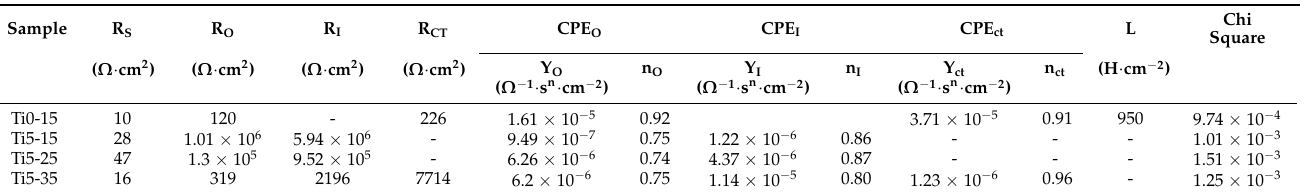
Figure 10. Equivalent circuits used to fit the EIS plots of ( a ) Ti5-15 and Ti5-25, ( b ) Ti0-15 and ( c ) Ti5-35. Table 6. Electrochemical parameters of EIS of Ti0-15, Ti5-15, Ti5-25 and Ti5-35 soaked in 3.5% sodium chloride solution for 336 h.